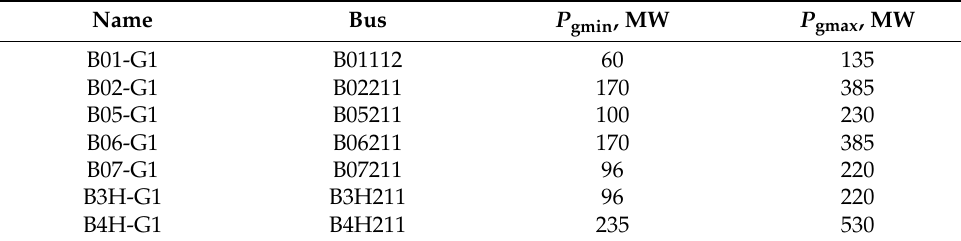
Table 1. List of sources.